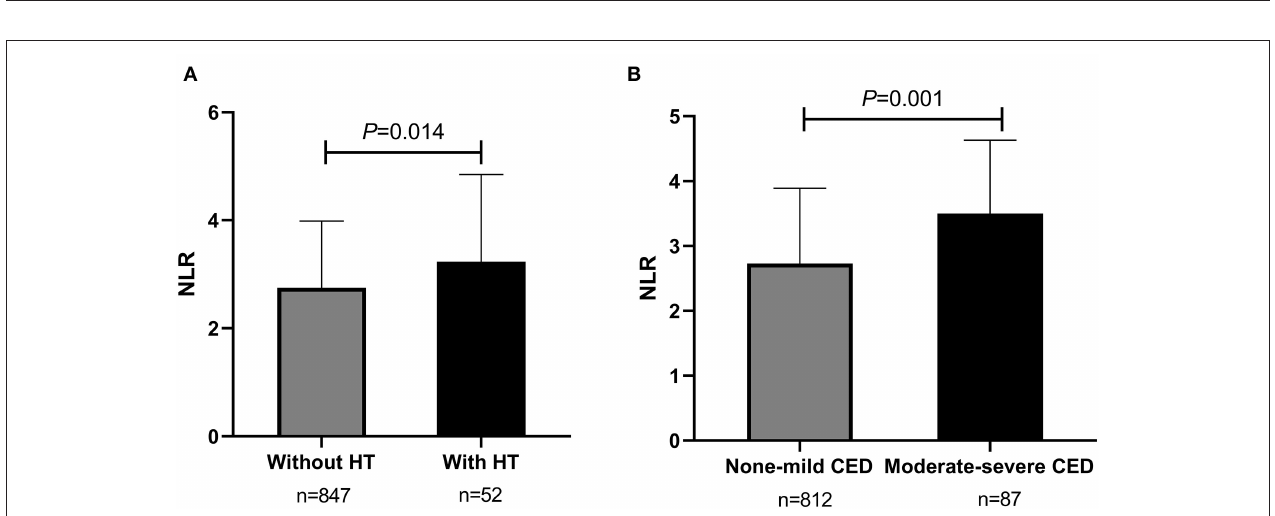
FIGURE 2 | Comparisons of admission NLR levels according to HT and CED in sICAS patients. (A) Comparison of admission NLR levels according to HT (without HT vs. with HT). (B) Comparison of admission NLR levels according to CED (none-mild CED vs. moderate-severe CED). P < 0.05 was considered statistically significant. NLR, neutrophil-to-lymphocyte ratio; sICAS, symptomatic intracranial atherosclerotic stenosis; HT, hemorrhagic transformation; CED, cerebral